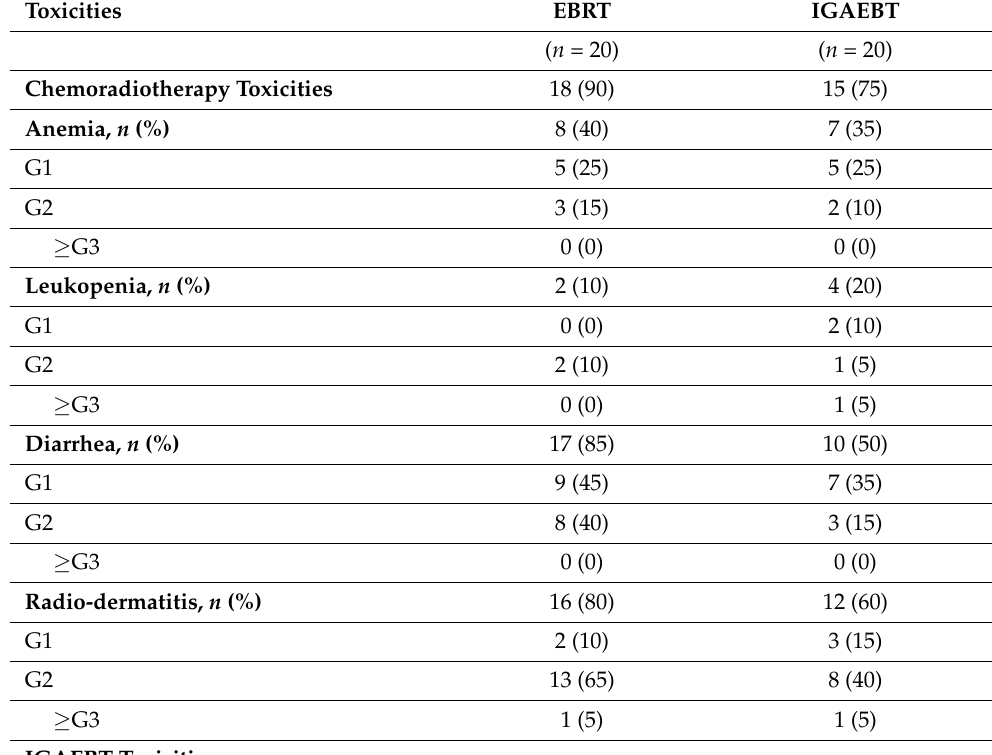
Table 2. Acute radiation-related and chemotherapy-related toxicity outcomes by trial